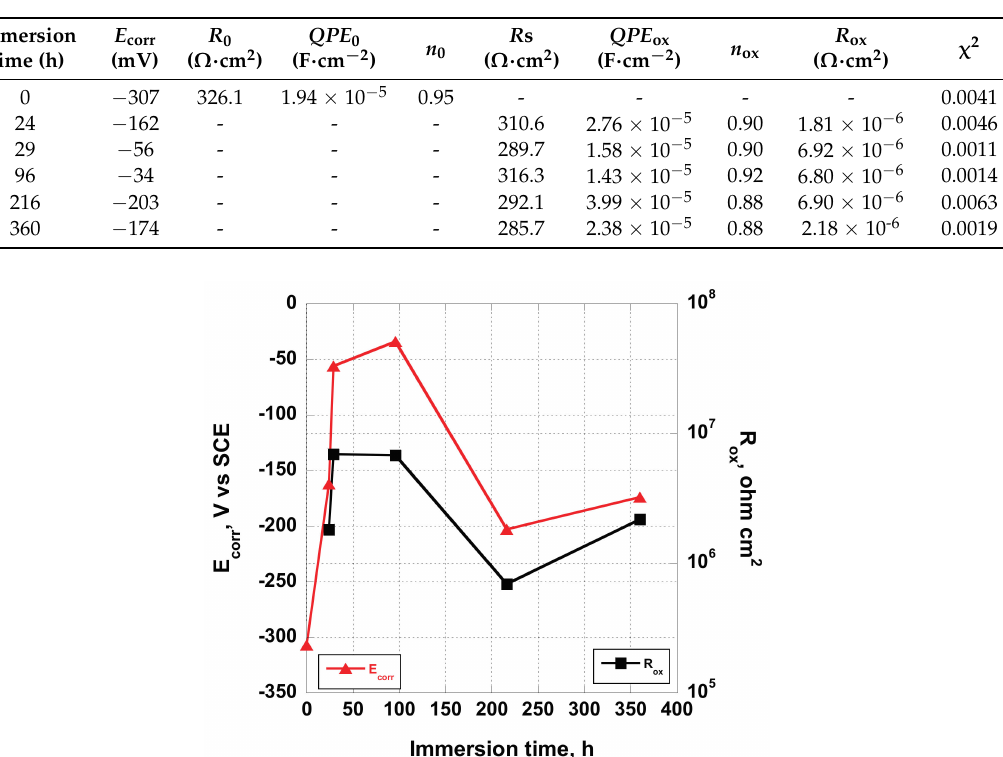
Table 7. Value of circuit equivalent elements for AS samples.